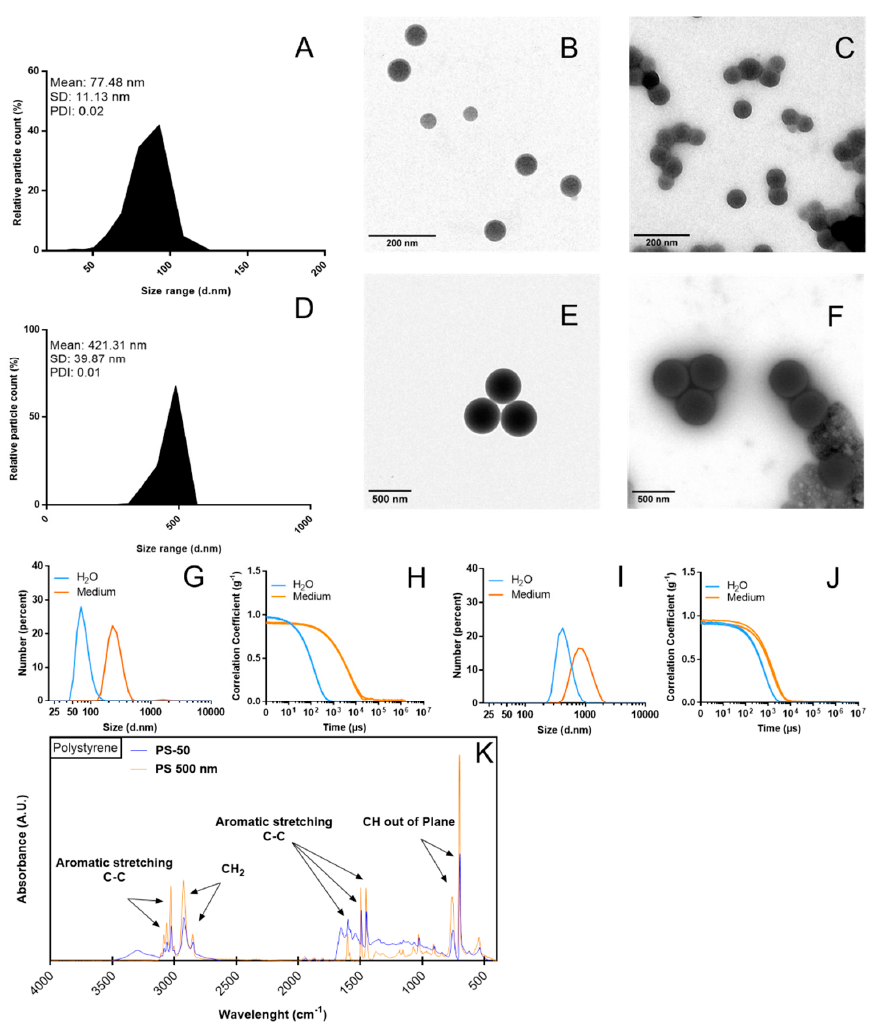
Figure 1. Particle size distribution (number percent) in Milli-Q water dispersion and the culture medium can be observed for both PS-50 ( A – C ) and PS-500 ( D – F ). The changes in hydrodynamic size and the correlation of the measurements are detailed for PS-50 ( G , H ) and PS-500 ( I , J ). The chemical composition of PS-50 (blue curve) and PS-500 (orange curve) shows the major functional groups measured by FTIR ( K ). d.nm, diameter in nm. PDI, polydispersity